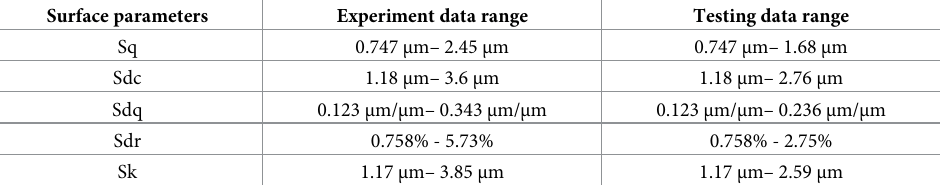
Table 3. Data range of surface